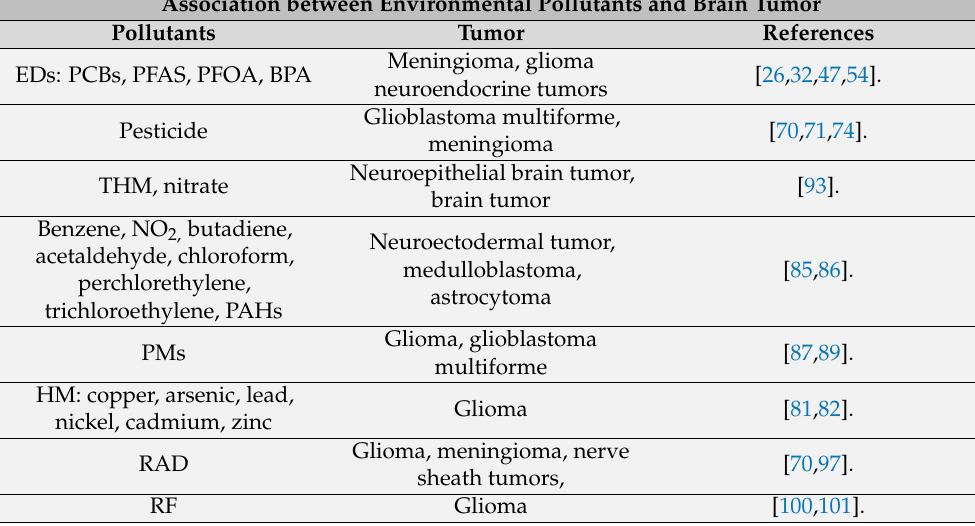
Table 1. Association between environmental pollutants and brain tumor . List of pollutants and their corresponding brain tumors. EDs: endocrine disruptors; PCBs: polychlorinated biphenyls; PFAS: polyfluoroalkyl substances; PFOA: perfluorooctanoic acid; BPA: Bisphenol A; THM: trihalomethanes; NO 2 : nitrogen dioxide; PAHs: polycyclic aromatic hydrocarbons; PMs: particulate matters; HM: heavy metal; RAD: ionizing radiation; RF: radiofrequency